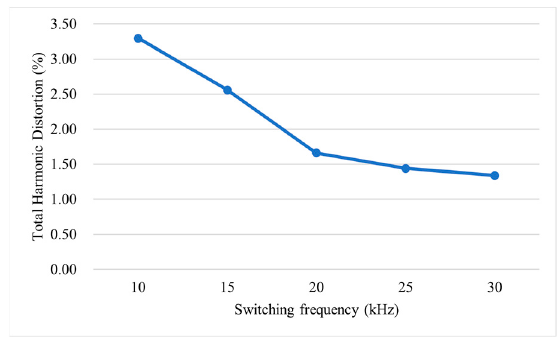
Figure 18. The grid current THD with different switching